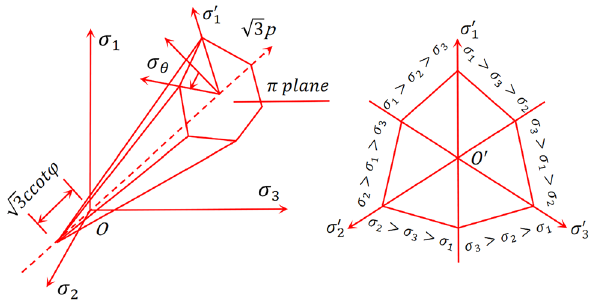
Fig. 1 Mohr–Coulomb yield criterion in principal stress space and π